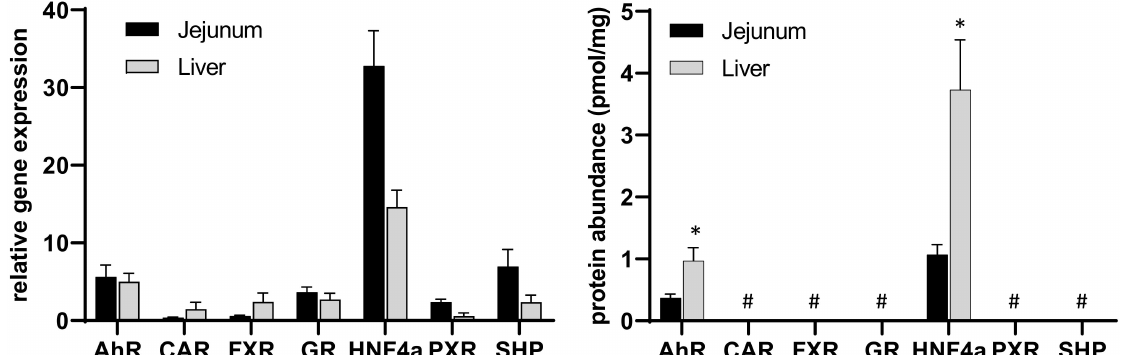
Figure 2. Data on gene expression ( left ) and protein abundance ( right ) of the investigated nuclear receptors in human jejunum and liver where, in each case, N = 8 different donors (inter-subject com- parison). Data given as mean ± SD. *: p ≤ 0.05 compared to jejunum, #: < lower limit of